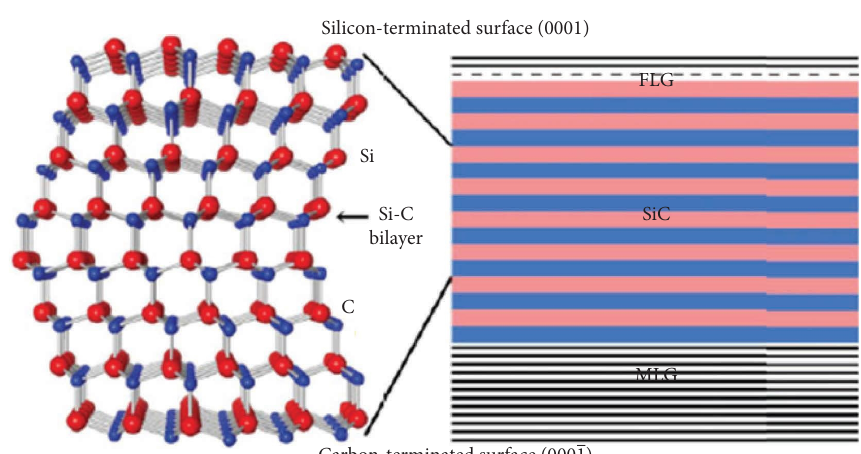
Figure 11: SiC crystal with reference to (0001) surface and (0001) surface